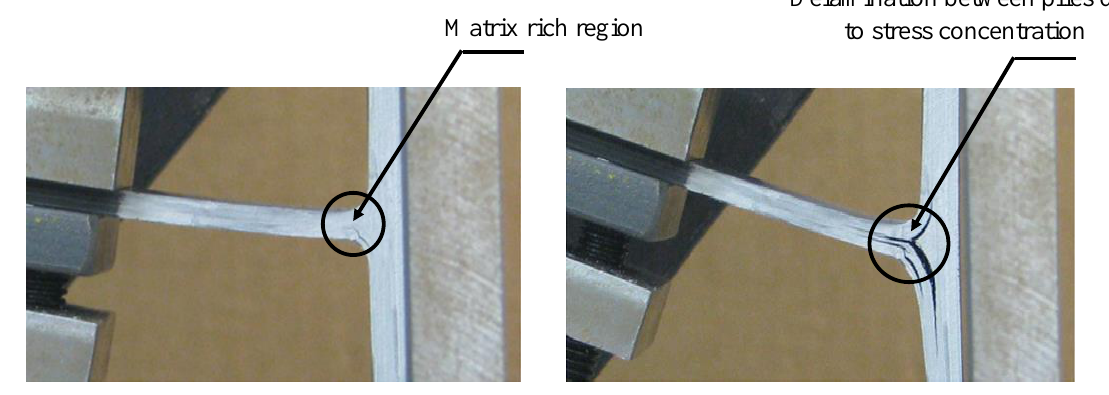
Figure 1: Stress concentration in composite T-joint